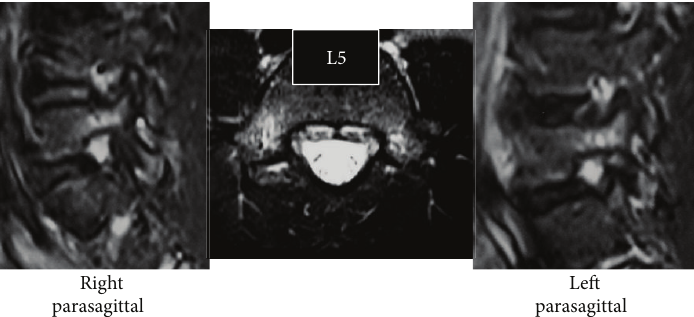
Figure 7: STIR-MRI of Case 3. Note the high signal changes of the pedicle, indicating marrow edema. This is a sign that the adjacent pars would have an early stage stress fracture of the pars